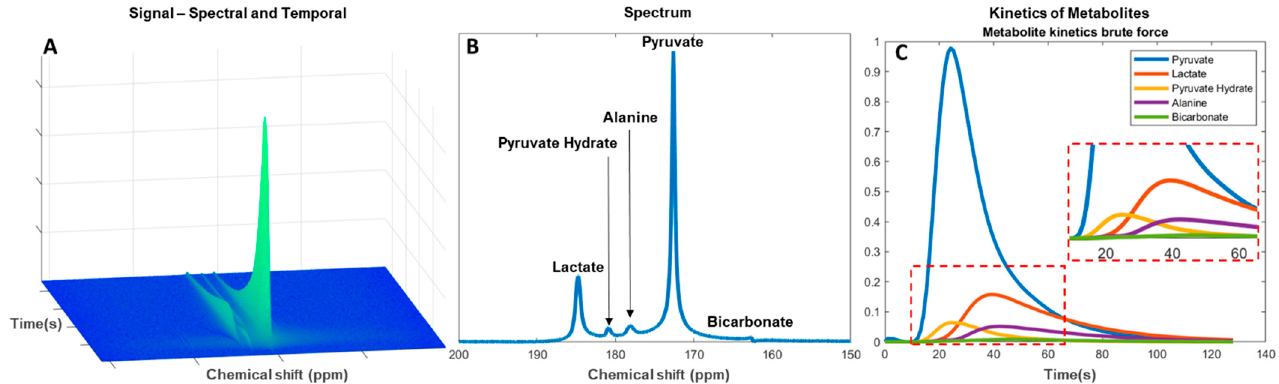
Figure 4. Analysis of hyperpolarized carbon-13 spectra from pyruvate injection. ( A ) Metabolite signal change in the spectral and temporal dimension since injection. ( B ) Total signal of downstream metabolites in a temporal summed spectrum. ( C ) Kinetics of the metabolites with enhanced view of smaller signal metabolites (red dashed box).